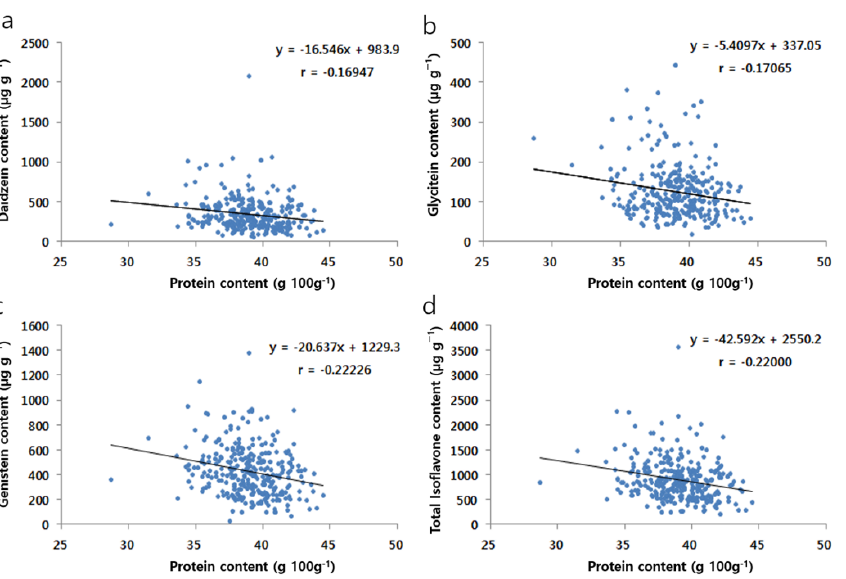
Figure 3. Relationship among daidzein ( a ), glycitein ( b ), genistein ( c ) and total isoflavone ( d ) and protein contents in 300 soybean germplasms.